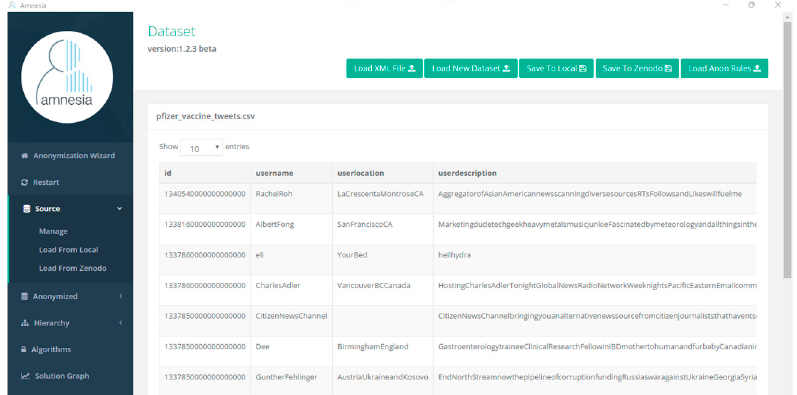
Figure 11. Dataset uploaded in Amnesia.